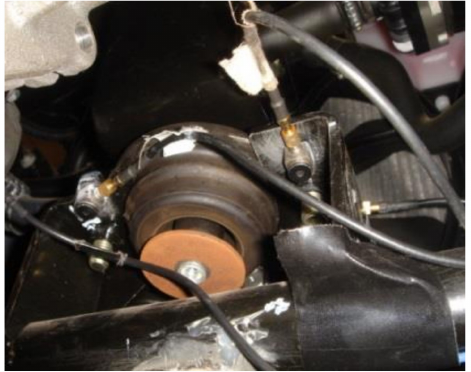
Figure 16. Arrangement of noise source excitation points on the mount front.